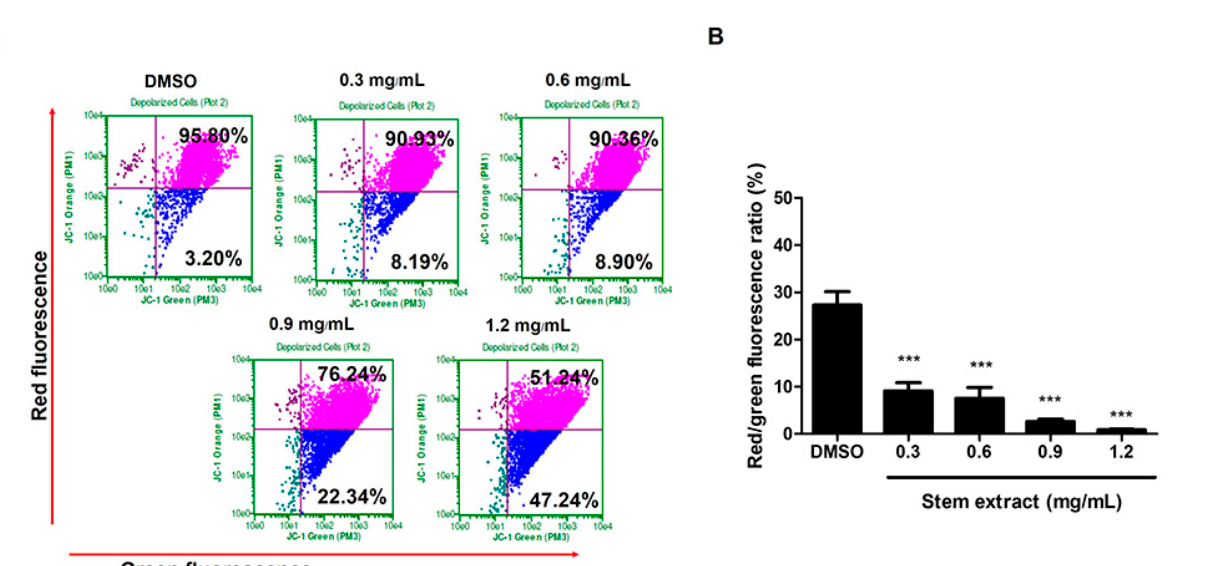
Figure 4. Effects of stem extract on the mitochondrial membrane potential ( ∆Ψ m) in PC-3 cells ( A ) Cells were treated with stem extract at 0, 0.3, 0.6, 0.9, and 1.2 mg/mL for 24 h. Next, all samples were stained with JC-1 and analyzed by flow cytometry. The upper right quadrant indicates polarized mitochondria (red fluorescence), while the lower right quadrant illustrates membrane depolarization (green fluorescence). ( B ) Quantification of the red/green fluorescence ratio indicates low membrane potential following increasing concentrations of the stem extract. *** indicates p < 0.0001 compared to the control.